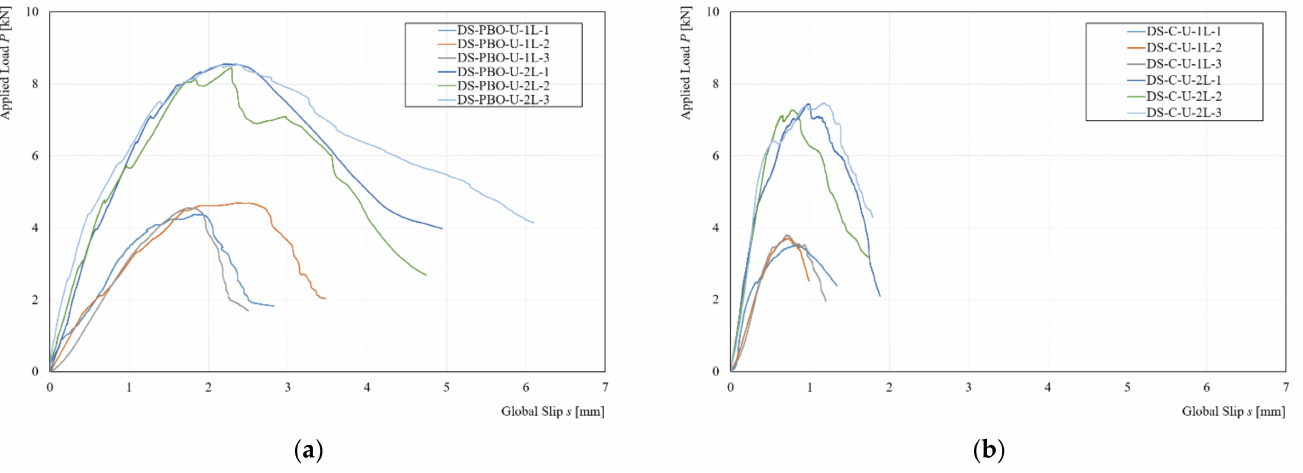
Figure 6. Experimental curve of unconditioned specimens: ( a ) PBO-FRCM and ( b )